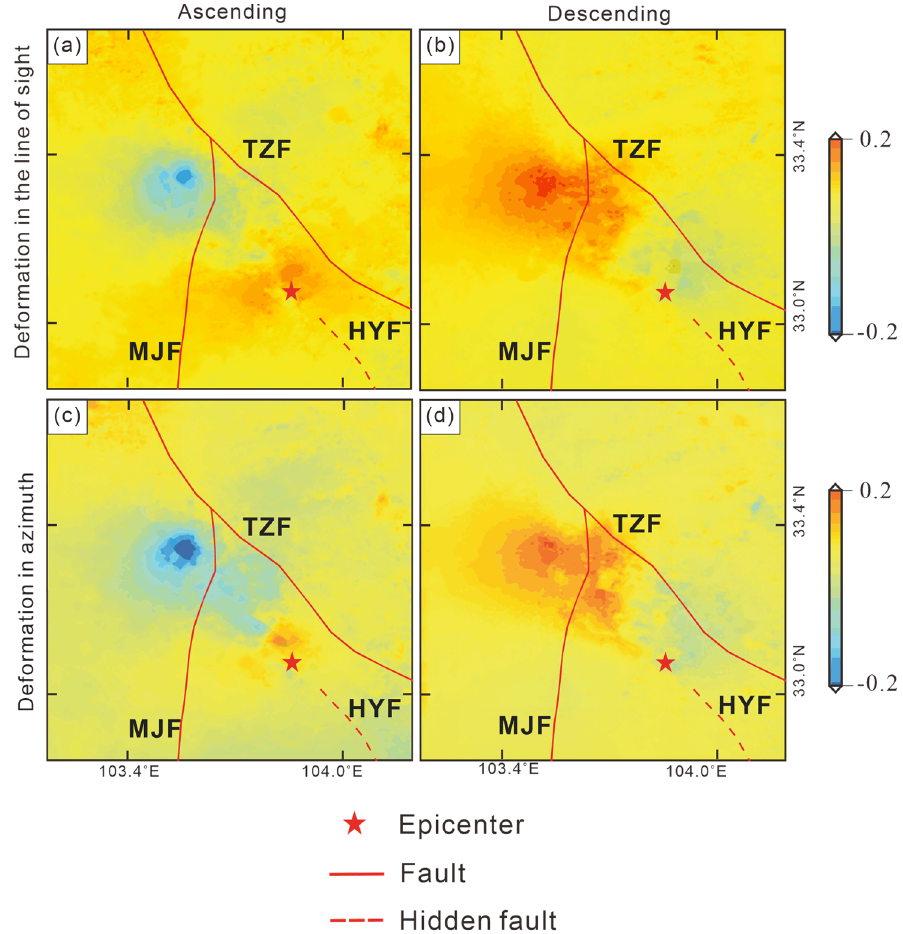
Figure 10. Deformation field of the Jiuzhaigou earthquake generated from combined D-InSAR and MAI method. Panels ( a ) and ( b ) are deformation of InSAR line of sight along ascending and descending orbits, respectively; ( c ) and ( d ) represent the deformation fields of InSAR azimuth direction along ascending and descending orbits, respectively.